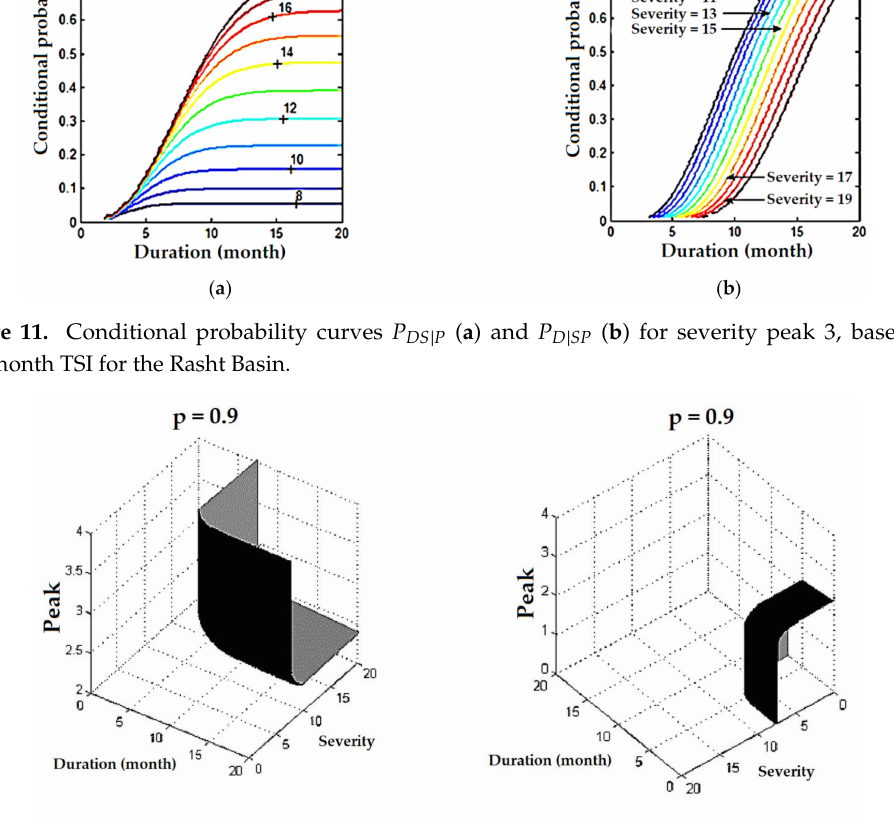
Figure 12. Location of points that have the same joint probability P ∨ ( b ) based on one-month TSI for the Rasht